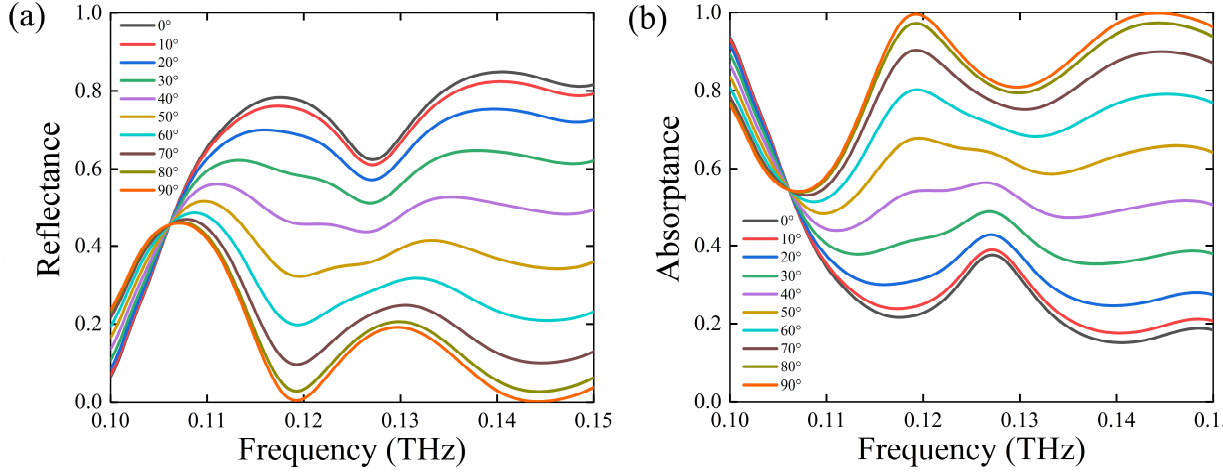
Figure 7. ( a ) The simulated reflectance spectrum and ( b ) absorptance spectrum for U at the frequency ranging from 0.1 to